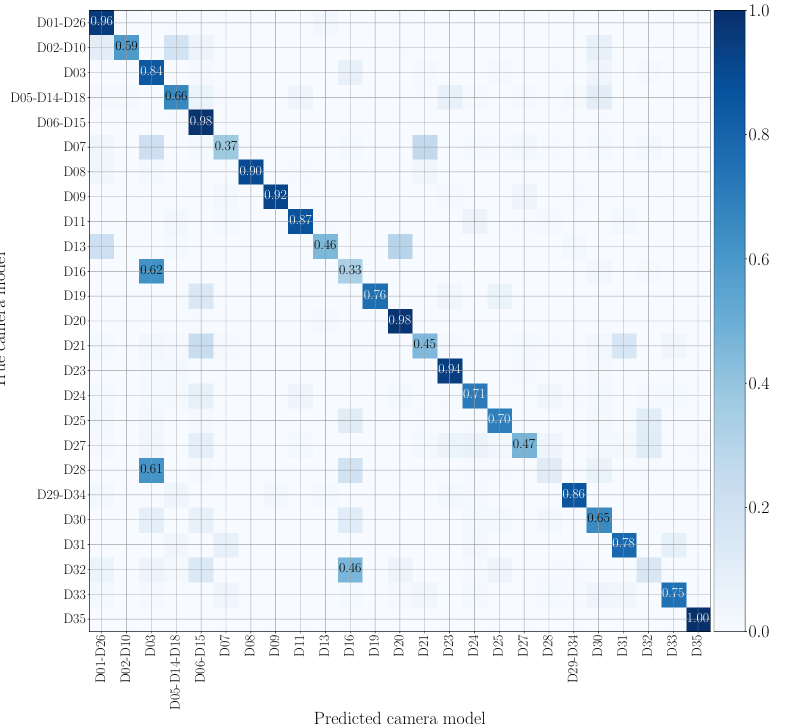
Figure 13. Confusion matrix achieved by multi-modal camera model identification exploiting Early Fusion EV. We report results by training on the native video set and testing on WhatsApp videos, and we only show the numbers that exceed 0.3. Device nomenclature is that of [44].